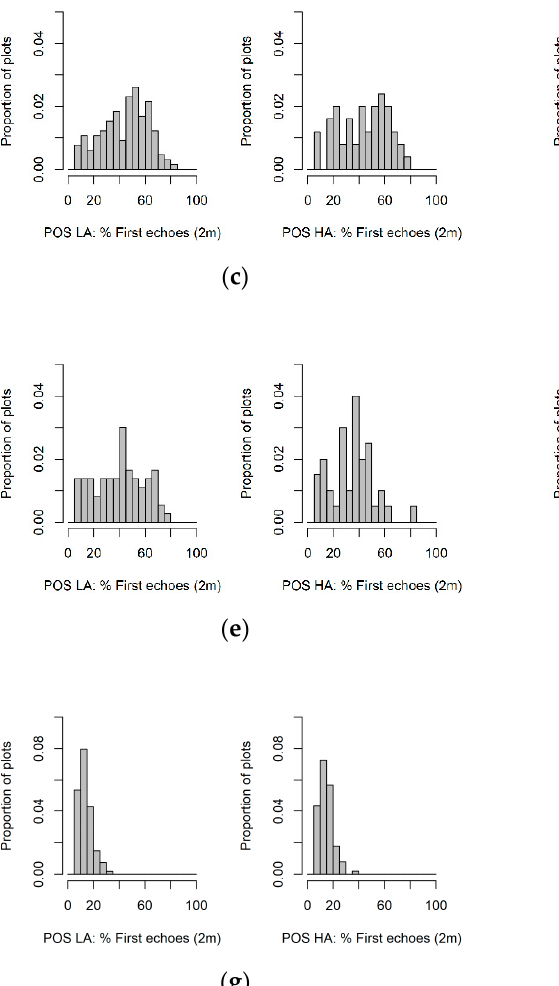
Figure A2. Histograms of the percentage of first ALS echoes above 2m in the sample plots. The results are presented for low- and high-accuracy measurements and for the seven forest ecosystems assessed: Dehesa ( a ), Encinar ( b ), Pinaster ( c ), Eucalyptus ( d ), Pinea ( e ), Canario ( f ) and Fayal-Brezal ( g ).